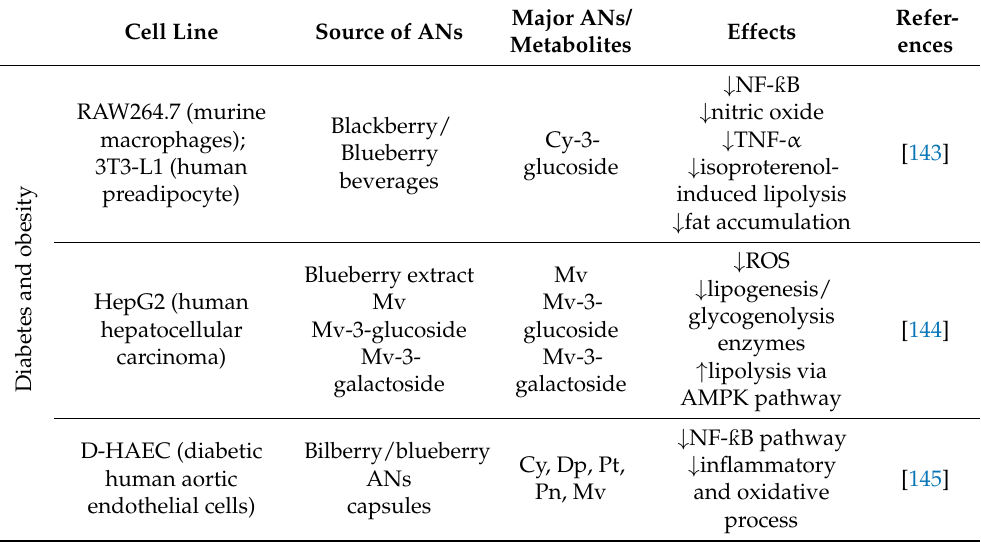
Table 1. In vitro studies of ANs showing their involvement in different pathologies such as diabetes, obesity, cancer, neurological, and